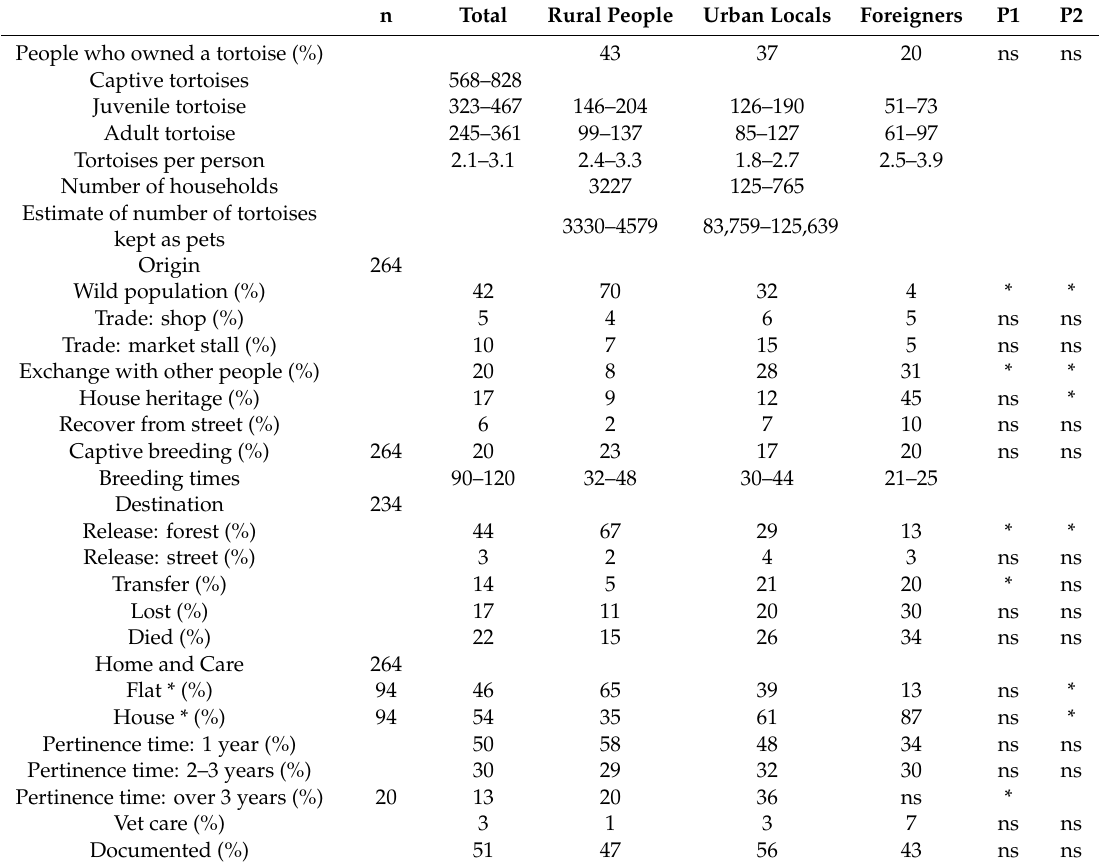
Table 4. Results of the surveys in the study area, in urban and rural areas for local and foreign people. Minimum and maximum numbers of captive tortoises were calculated according to the ranges of the questionnaire (tortoises kept: between two and four were assigned to two as a minimum and four as a maximum, while over four was assigned to five). The same procedure was followed to estimate breeding times. Di ff erences between rural people and urban local (P1) and rural people and foreigners (P2); ns (statistically not significant) and * ( p < 0.05). Flat and house were assigned only to people who currently had tortoises, and not those who had had them in the past.